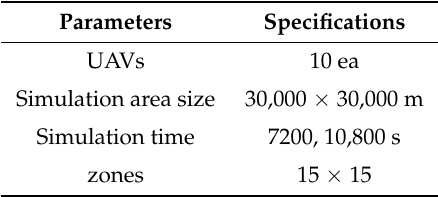
Table 4. Simulation